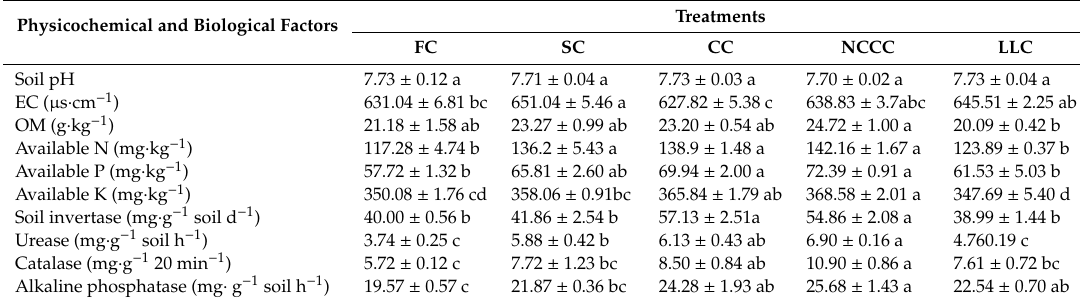
Table 2. E ff ects of di ff erent planting system on soil physicochemical and biological characteristics of autumn–winter (AW)